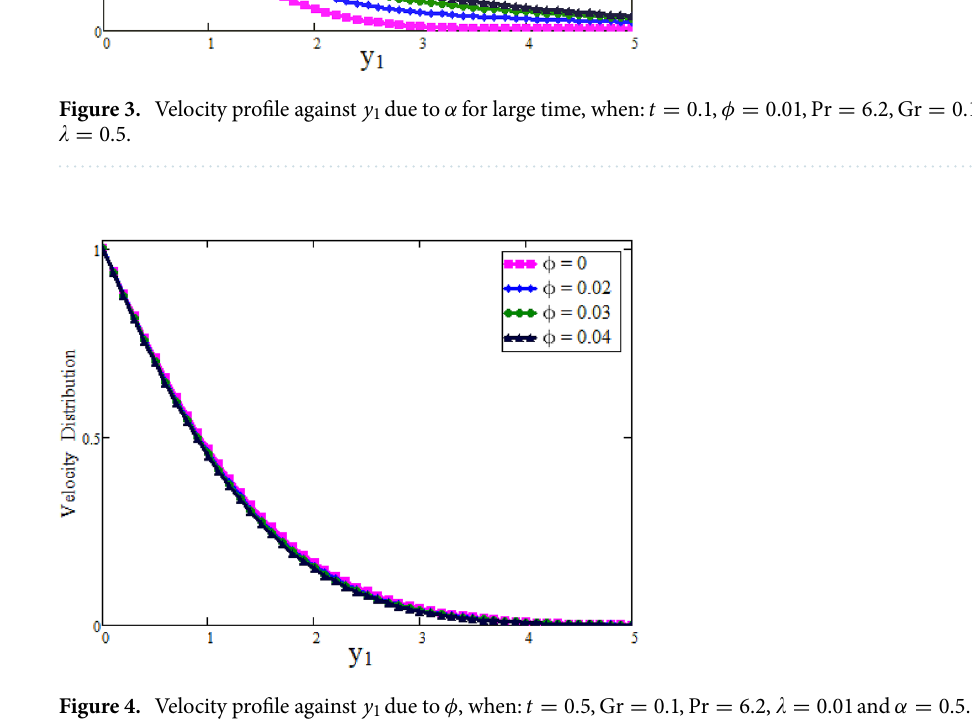
Figure 4. Velocity profile against y 1 due to φ , when: t = 0.5 , Gr = 0.1 , Pr = 6.2 , (cid:31) = 0.01 and α =